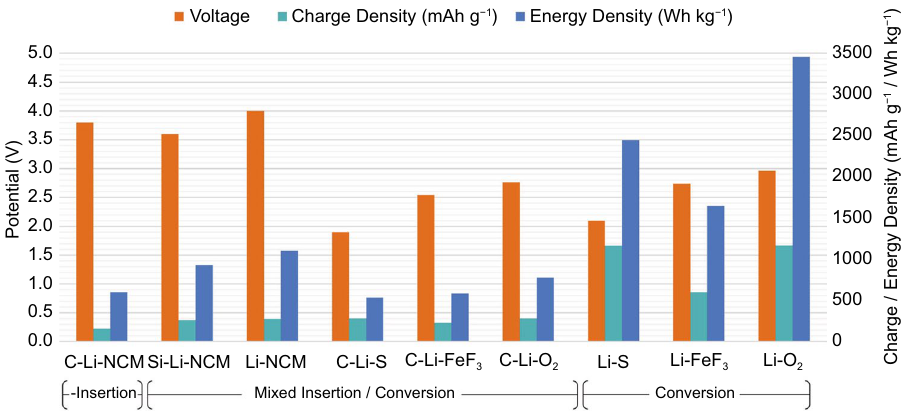
Fig. 10 Theoretical charge capacity, voltage, and energy density of different lithium battery